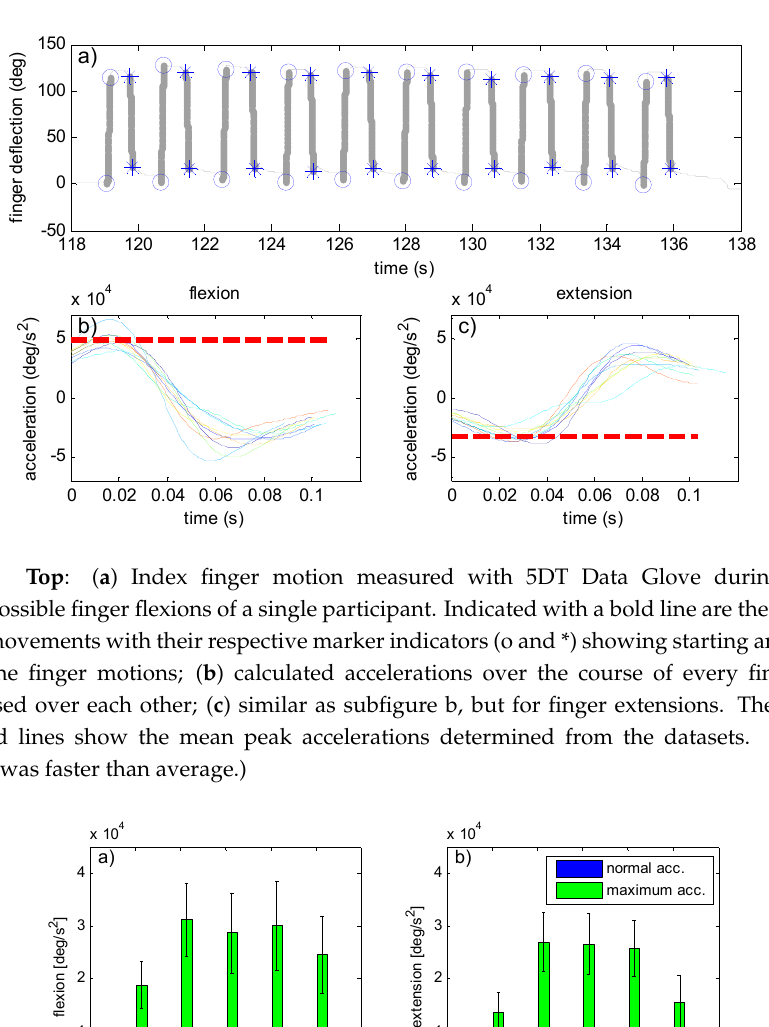
Figure B2. Mean peak accelerations (±SD) during finger flexion and extension performed at normal speed (blue) and as fast as possible (green), calculated per participant and subsequently averaged over all 10 participants. ( a ) finger flexion measurements; ( b ) finger extension measurements.